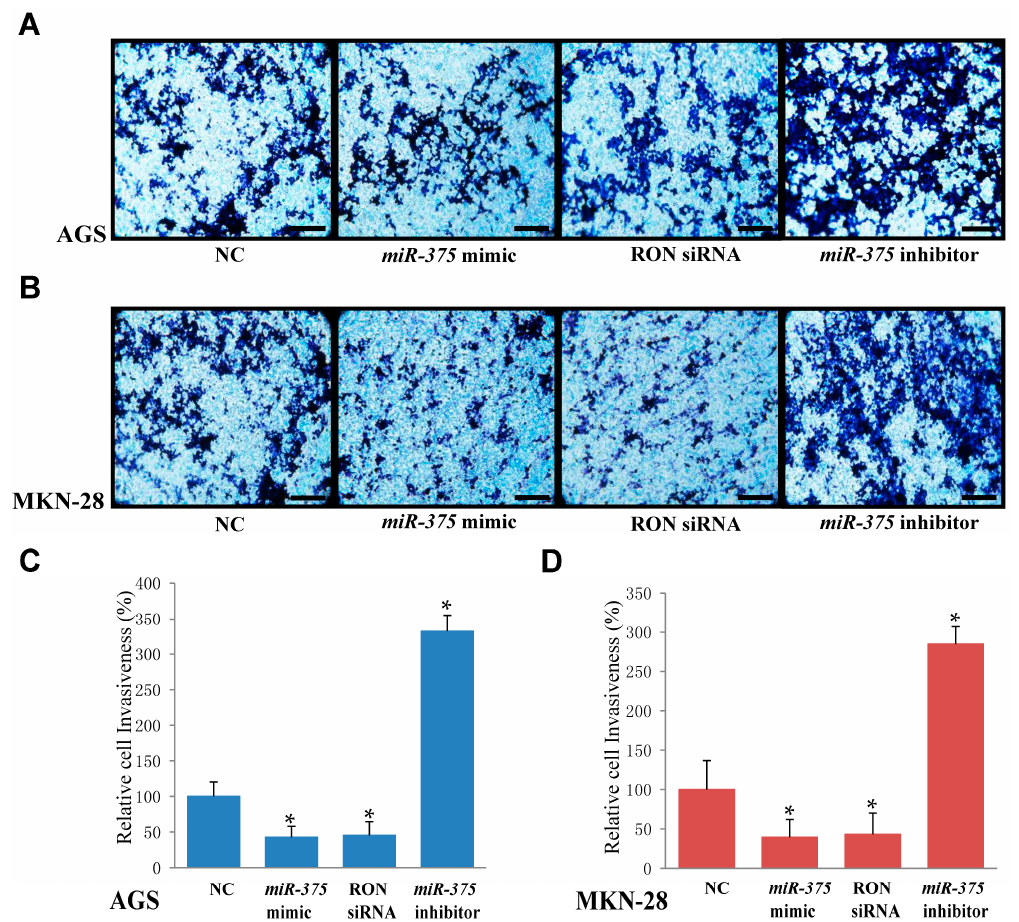
Figure 6. Overexpression of miR-375 or knockdown of RON inhibits cell invasion in AGS and MKN-28 cells. ( A , C ) A modified Boyden chamber assay was performed to evaluate the effect of miR-375 or RON on the invasive ability of AGS; ( B , D ) A modified Boyden chamber assay was performed to evaluate the effect of miR-375 or RON on the invasive ability of MKN-28 cells. * p < 0.05 versus negative control; The data represent the mean ± SD from triplicate measurements. Scale bars: 100 μ M in ( A , B ).